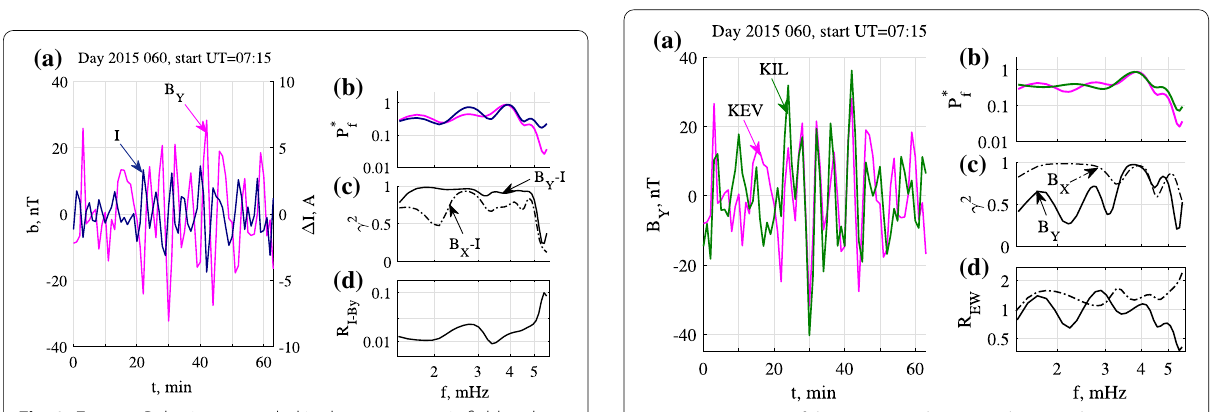
Fig. 3 Parameters of the event 1 pulsation in the E–W direction: a B Y waveforms at KEV (magenta) and KIL (green); b normalized PSD spectra; c E–W spectral coherence for B Y (solid) and B X (dashed); d E–W PSD ratio for B Y (solid), and B X